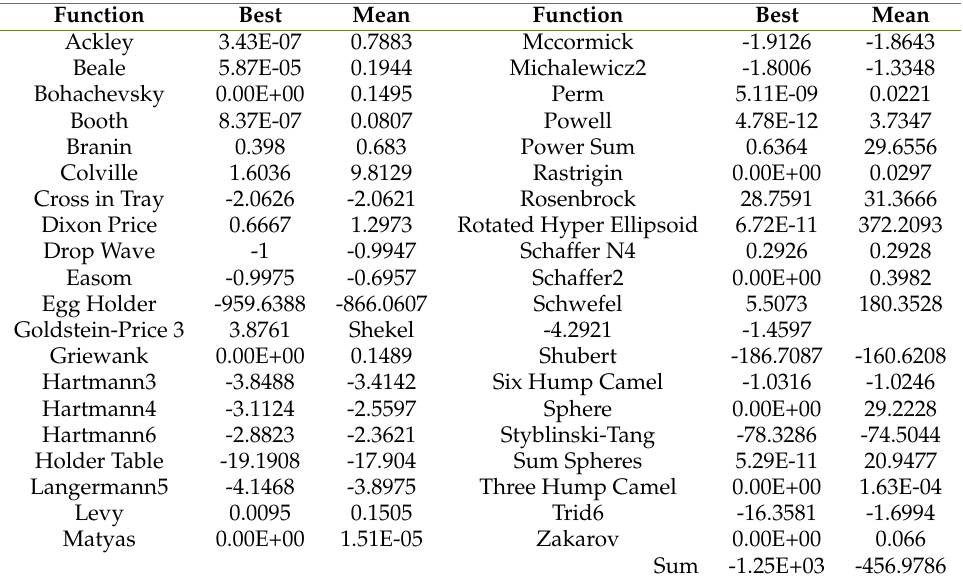
Table 6. Results of Cosine (AB) for a = 1.5